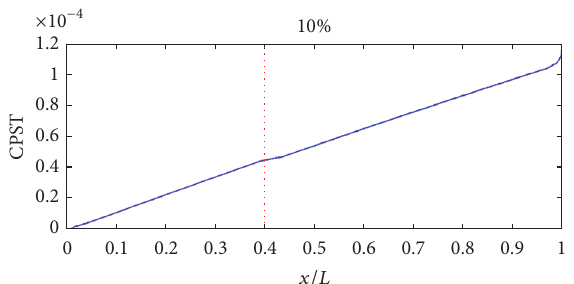
Figure 13: CPST of 10% damaged scenario using acceleration response with the mass which is 50 Kg.